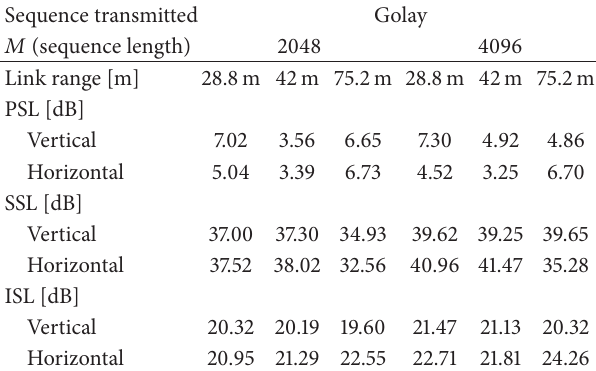
Table 4: Results for PSL, SSL, and ISL parameters—Golay